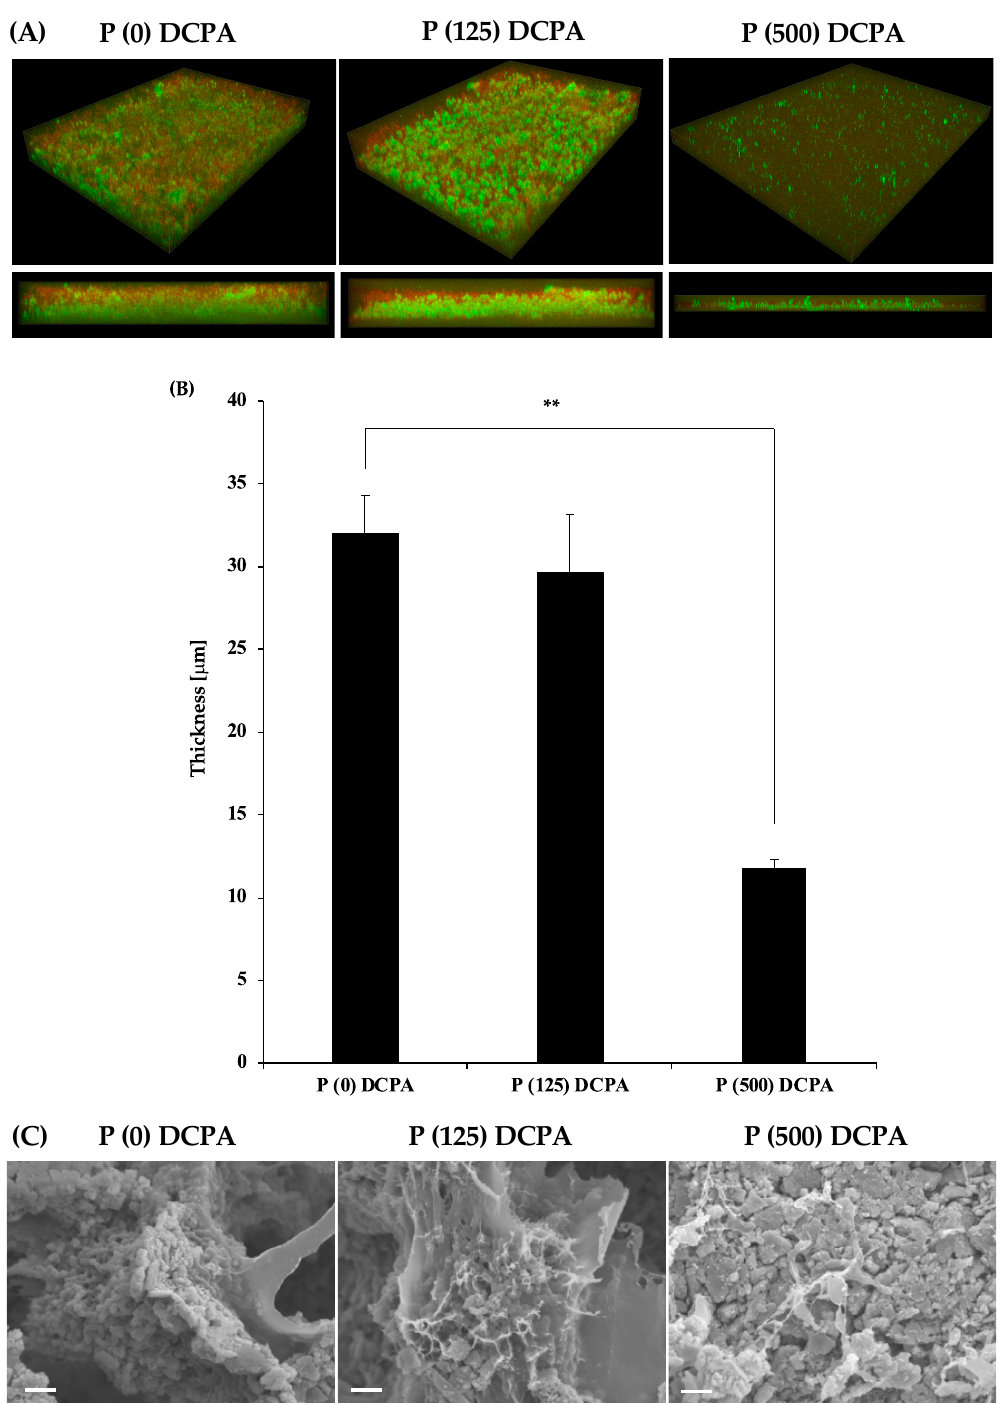
Figure 3. Antimicrobial activity of protamine-loaded DCPA fabricated discs in culture conditions with 1% sucrose. S. mutans (4 × 10 6 CFU · cm − 3 ) were incubated in 1 / 10 concentration of media containing 1% sucrose for each disc (P (0) DCPA, P (125) DCPA, P (500) DCPA) for 24 h. Error bars indicate the standard error of the mean ( n = 3). The asterisks show ** p < 0.01 by Student’s t -test. ( A ) Three-dimensional architecture and cross section of the biofilm on the disc stained by SYTO ® 9 and dextran conjugates. Live bacteria appear green and extracellular polysaccharides (EPS) appear red. ( B ) Thickness of the biofilm measured by image analysis. ( C ) SEM image of the biofilm on the disc surface. Bars represent 2.0 μ m.